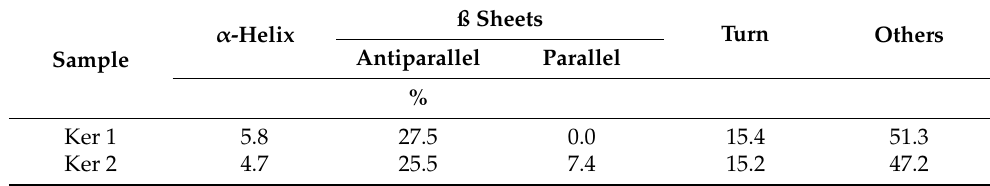
Figure 3. Circular dichroism spectra of lyophilized keratins. Table 2. Secondary structure percent composition obtained with BeStSel webserver for keratin